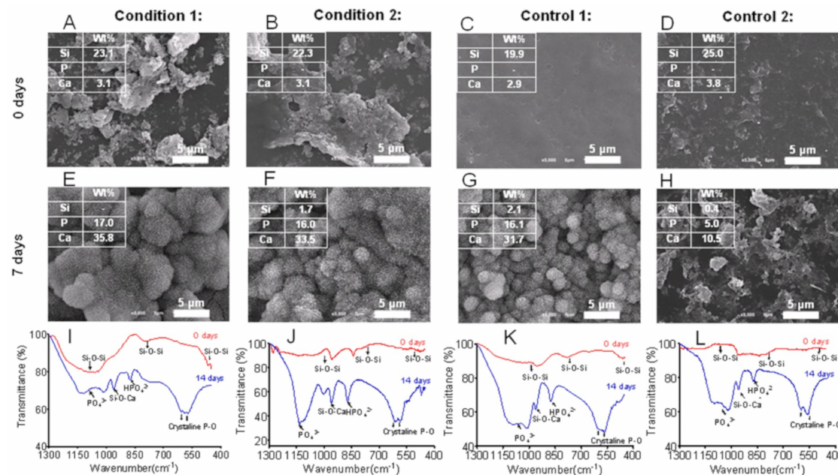
Figure 14. In vitro bioactivity studies. ( A – H ) Representative images of scanning electron microscopy with quantitative EDS analysis of four LBL film configurations (condition 1, [CHT / HA-C / CHT / BG] 5 - CHT / HA-C; condition 2, [CHT / HA-C / CHT / BG] 5 ; control 1, [CHT / HA / CHT / BG] 5 -CHT / HA; and control 2, [CHT / HA / CHT / BG] 5 ) ( A – D ) before and ( E – H ) after the immersion in simulated body fluid (SBF) for 7 days. ( I – L ) Corresponding FTIR spectra obtained before and after the immersion in SBF for 14 days. Reproduced with permission from Ref. [128], Copyright 2015, American Chemical